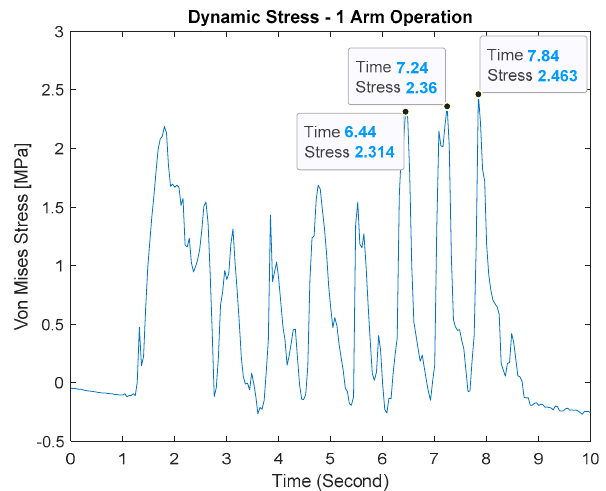
Figure 22 . Dynamic test result (single crank arm operation).